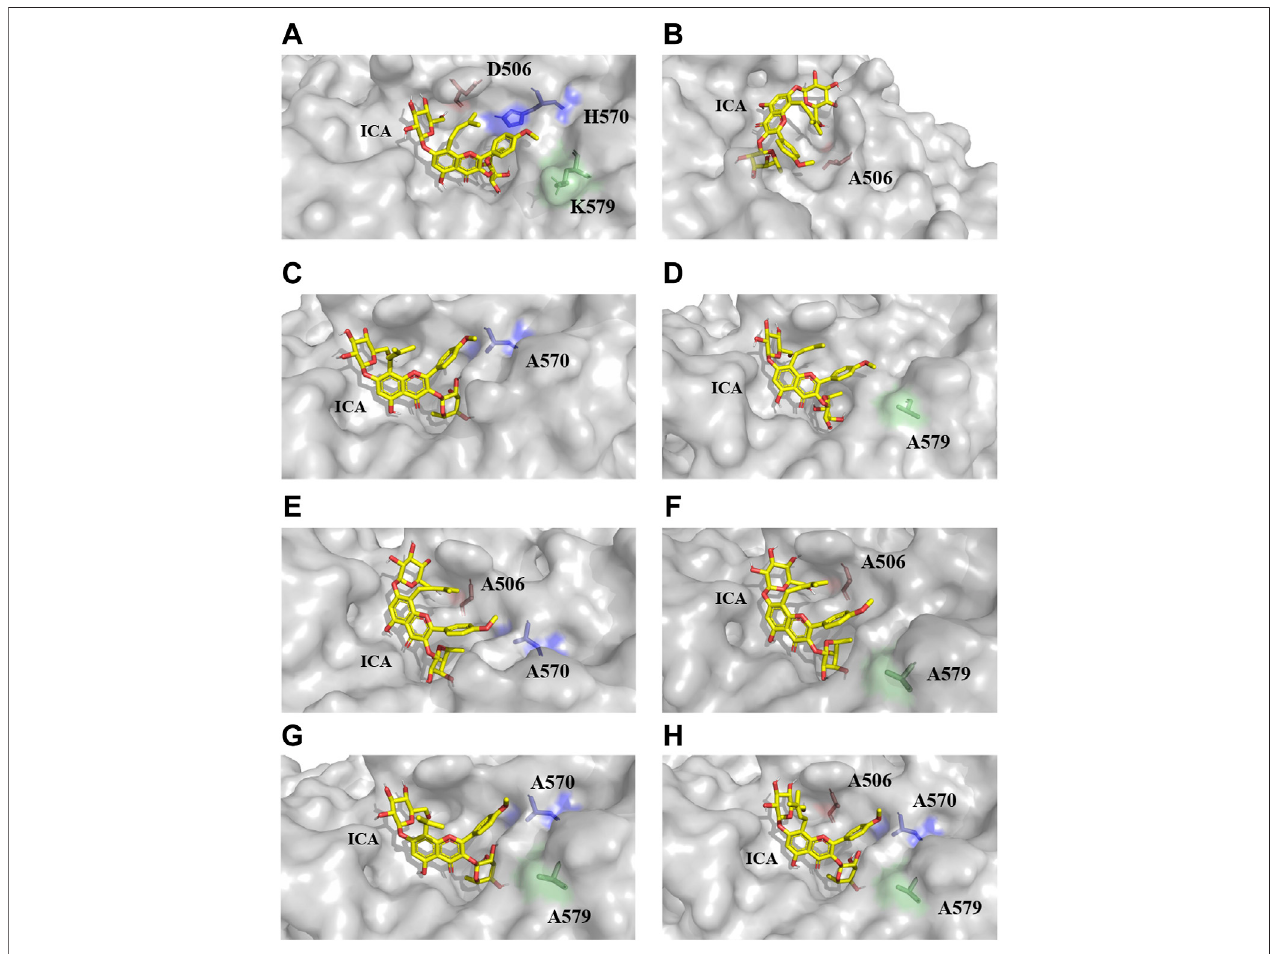
FIGURE 4 | The docking results of TpeRhas and icariin. The TpeRhas models are displayed as the surface type shown in gray, the icariin is displayed as stick type shown in yellow, the residue at position 506 is displayed as sticks type shown in salmon, the residue at position 570 is displayed as stick type shown in blue, and the residue at position 579 is displayed as stick type shown in green. (A) The conformation of docking complex TpeRha-icariin. (B) The conformation of docking complex D506A-icariin. (C) The conformation ofdocking complex H570A-icariin. (D) The conformation ofdocking complex K579A-icariin. (E) The conformation of docking complexDH-icariin. (F) TheconformationofdockingcomplexDK-icariin. (G) TheconformationofdockingcomplexHK-icariin. (H) Theconformationofdockingcomplex DHK-icariin.